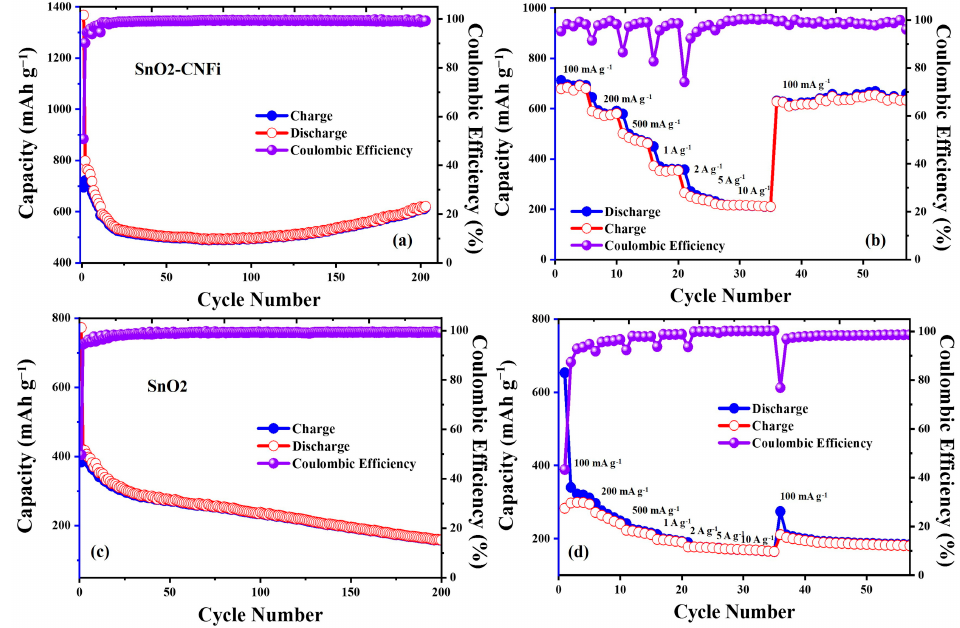
Figure 8. ( a , c ) Cycling performance and coulombic efficiency at 100 mA g − 1 and ( b , d ) rate capabilities of SnO 2 -CNFi nanocomposite and bare SnO 2 electrodes. Table 1. Cycling performance capacities of SnO 2 -CNFi/SnO 2 in comparison at 100 mA g − 1 . Composite